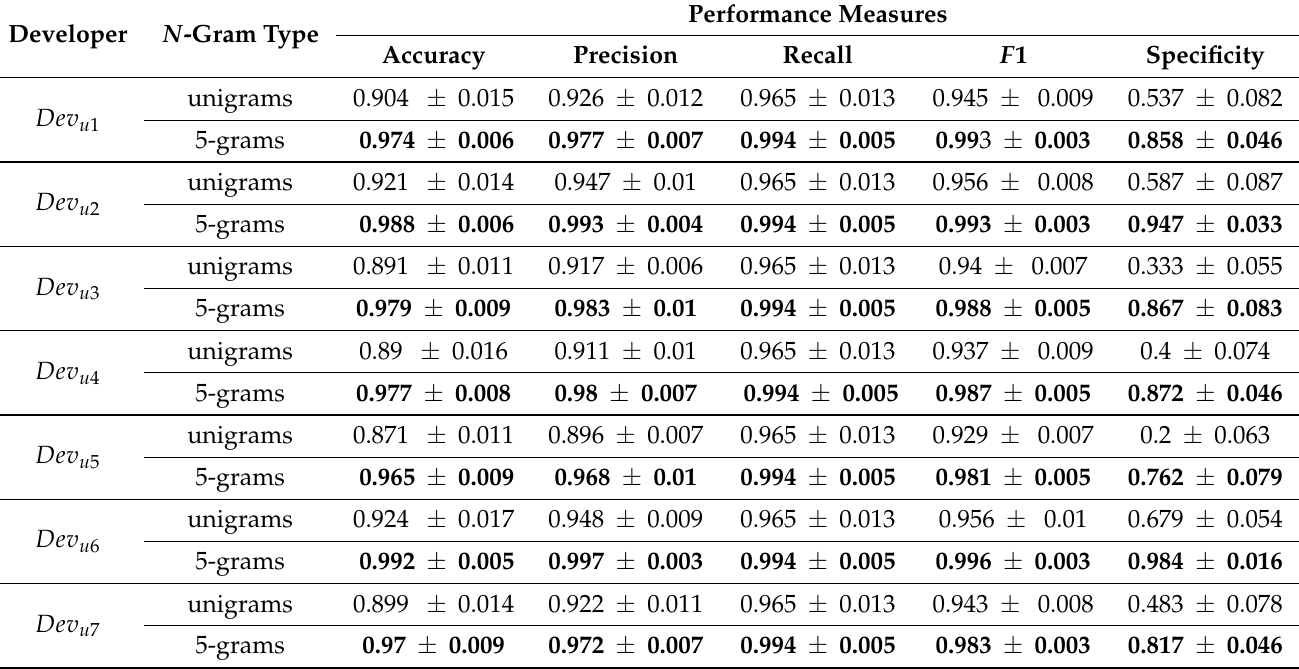
Table 4. AutoSoft ext results with respect to N -gram size for seven “unknown” authors and an O riginal set with n = 5. In addition, 95% confidence intervals are used for the